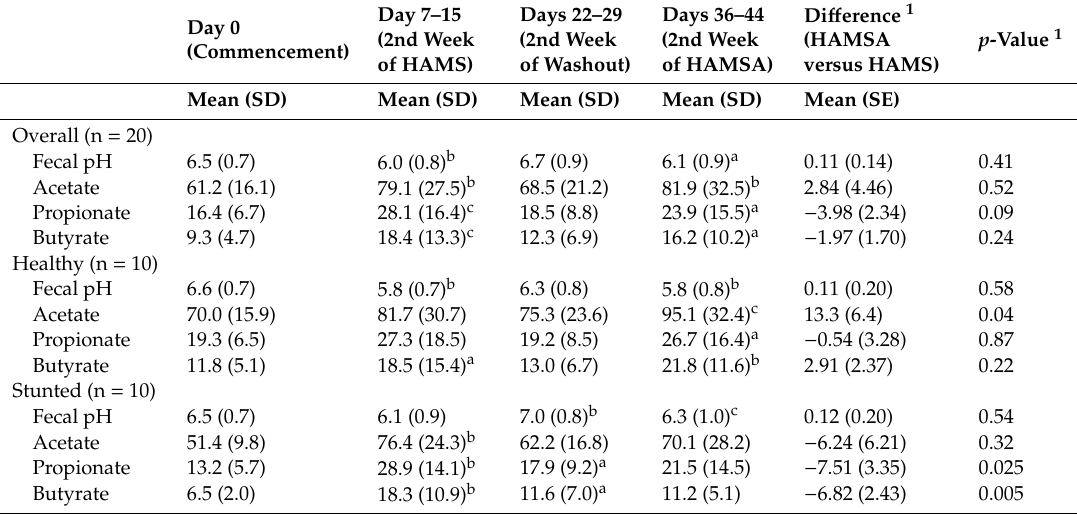
Table 2. Parameters of fecal fermentation (pH and short chain fatty acids (SCFA) concentrations, mmol / Kg feces) according to growth status at baseline and at the end of specific resistant starch (RS) interventions, together with di ff erences between HAMS and